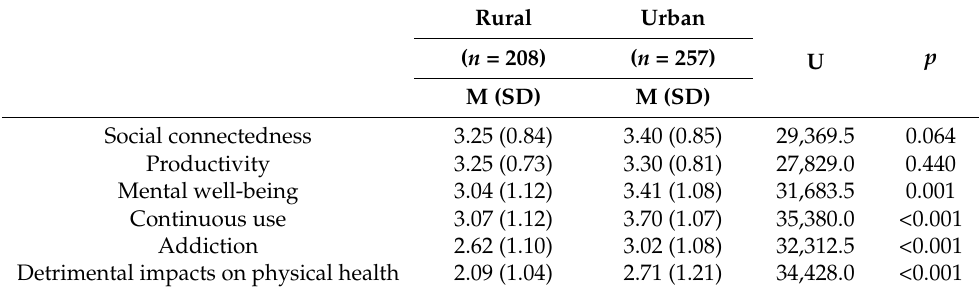
Table 2. Mobile device affinity and usage subscale scores among rural and urban